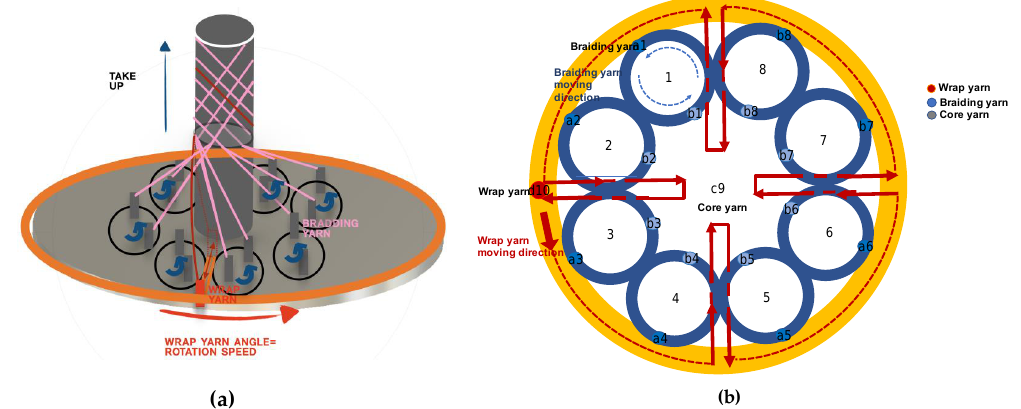
Figure 4. ( a ) The overall structure of the braiding machine. ( b ) The trajectory of the yarn movement of the braiding machine. Eight groups of braiding yarn tracks and one wrap yarn track used for braiding create a combination of spindle movements by repeating the same speed. The core yarn in c9